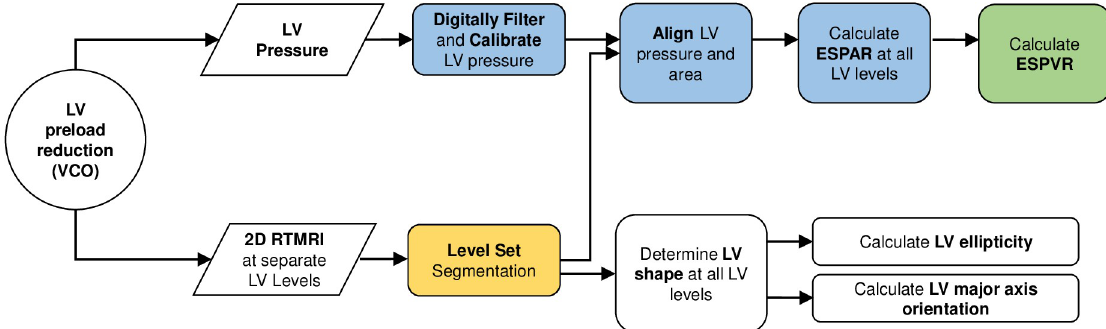
Fig 1. A flowchart illustrating the overall methodology designed to derive subject-specific ESPVR from RTMRI and LV pressure catheter measurement.